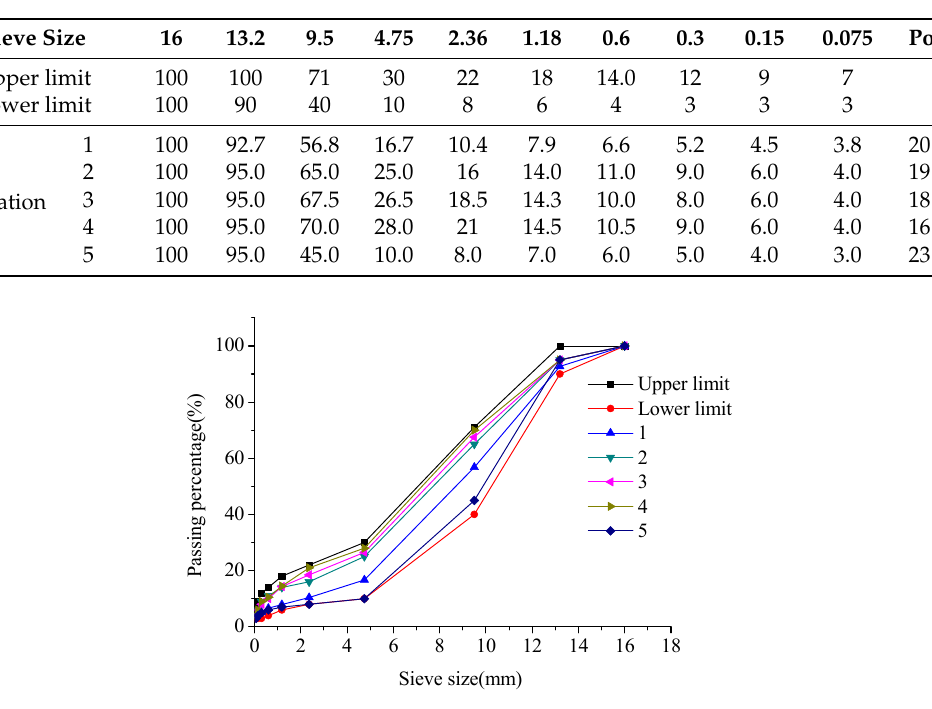
Table 4. Gradation of aggregate blends for asphalt mixture PAC13.